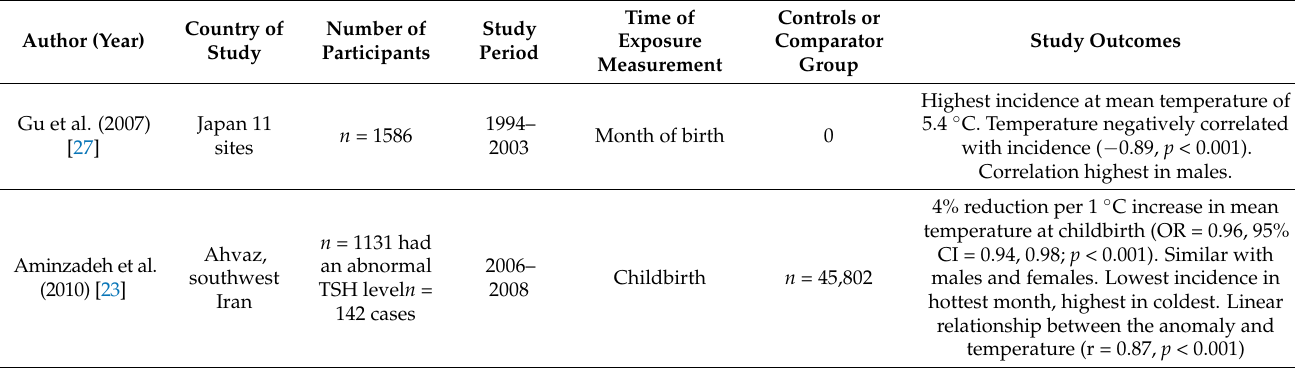
Table 4. Associations between heat exposure and congenital